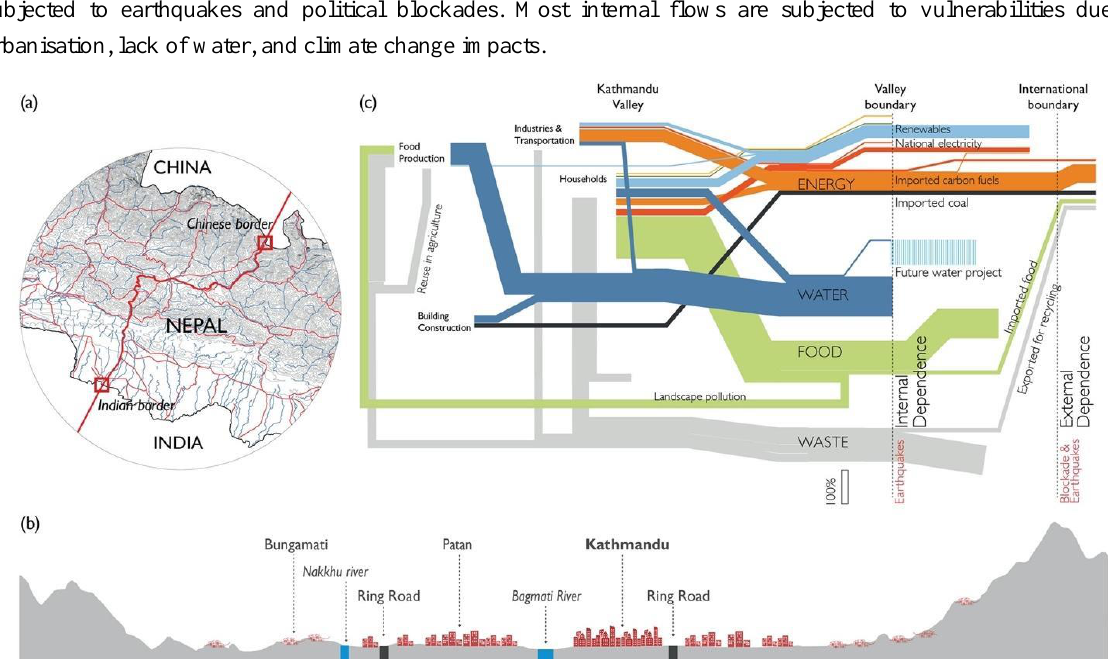
Figure 2. Interpreting the geopolitical landscape and its impact on the resource flows within Kathmandu valley; (a) Nepal's landlocked position; (b) the section of the Kathmandu valley highlighting its unique landscape condition; (c) interpreted flows map of critical resources, i.e. Energy, water, food and waste; Source: